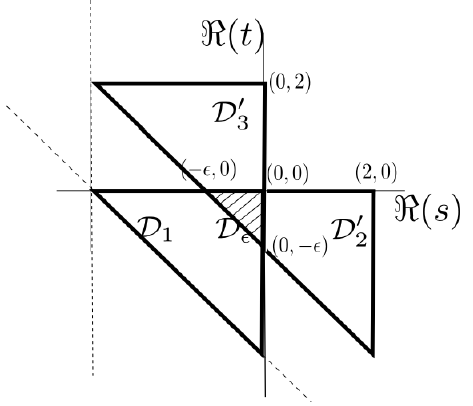
Figure 6 . The regularized domains. The common domain of size (cid:15) is depicted as the shaded region. multi-trace operators. While the multi-trace pieces are in general subleading, they can a(cid:11)ect the free-(cid:12)eld four-point function if the four weights are su(cid:14)ciently